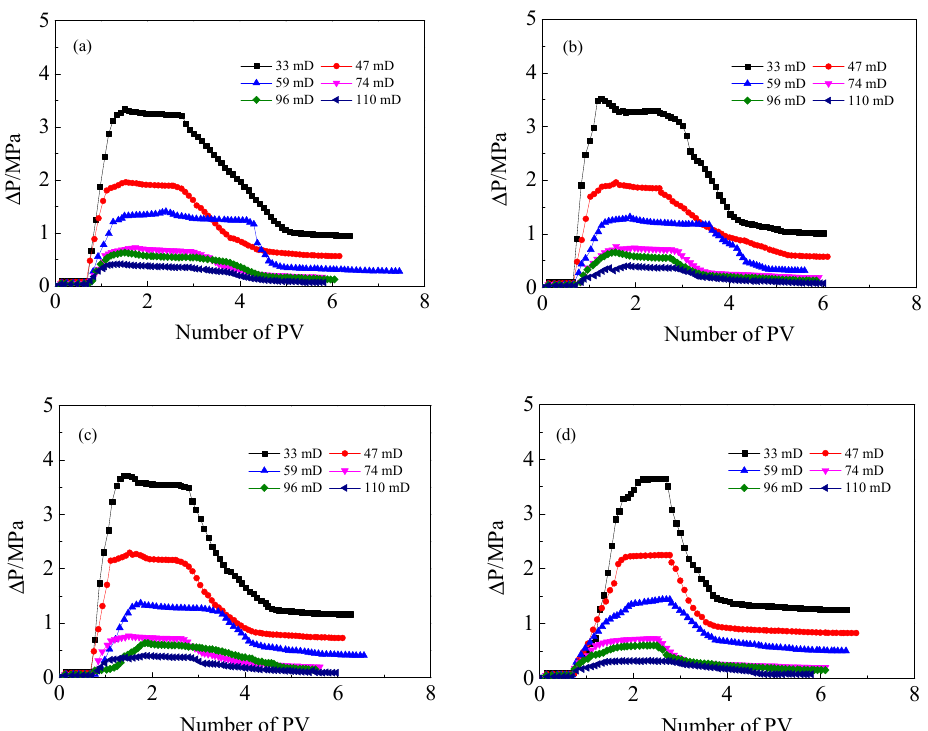
Figure 7. Pressure gradient ( Δ P) as a function of pore volume (PV) of injected in LW-HPAM/ANS flow in different permeability cores. ( a ) 0.8 g ⋅ L − 1 , ( b ) 1.5 g ⋅ L − 1 , ( c ) 2.3 g ⋅ L − 1 and ( d ) 3.0 g ⋅ L − 1 .